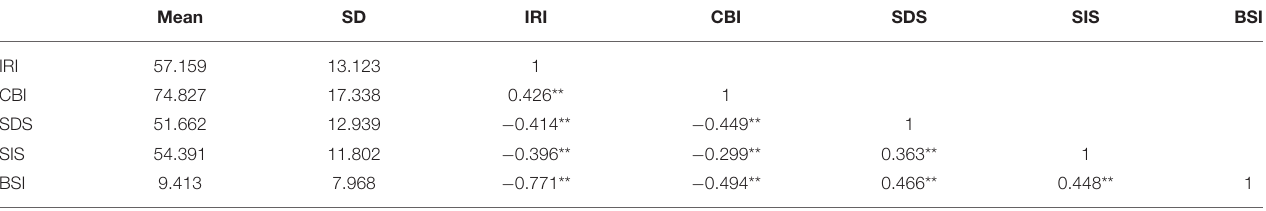
TABLE 3 | Correlations among social workers’ empathy ability (IRI), patients’ self-efficacy (CBI), depression symptoms (SDS), stigma (SIS), and suicide ideation (BSI) at T2. Mean SD IRI